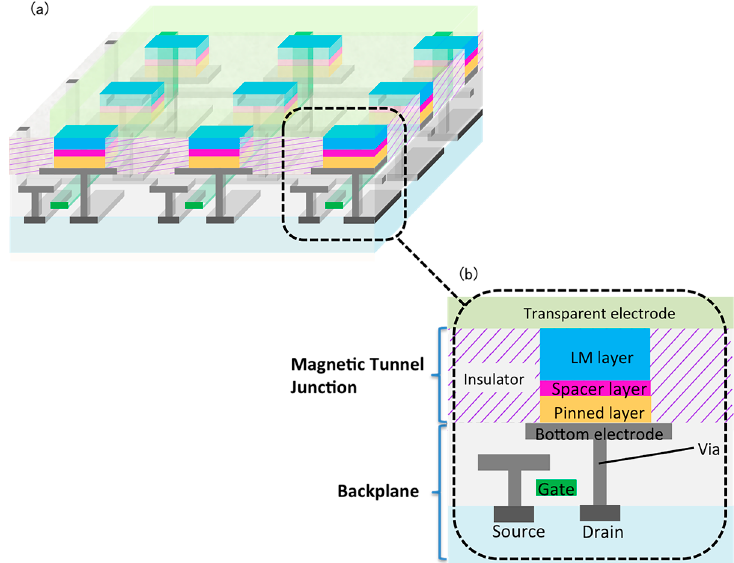
Figure 1. ( a ) Schematic and ( b ) cross-sectional illustration of the magneto-optical spatial light modulator (SLM) with submicron pixel sizes driven by spin-transfer switching (spin-SLM).